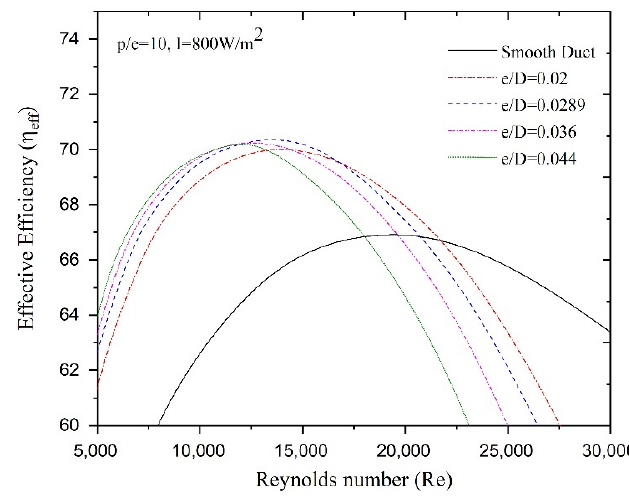
Figure 6. Effect of temperature increase parameter on effective efficiency.